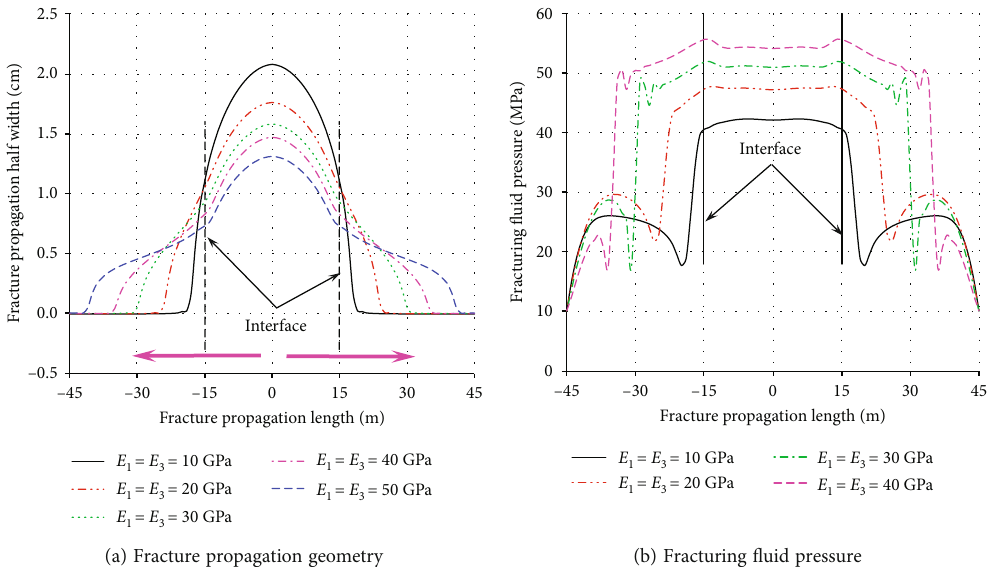
Figure 7: E ff ect of modulus contrast on the fracture propagation geometry and fracturing fl uid pressure within the crack surface.